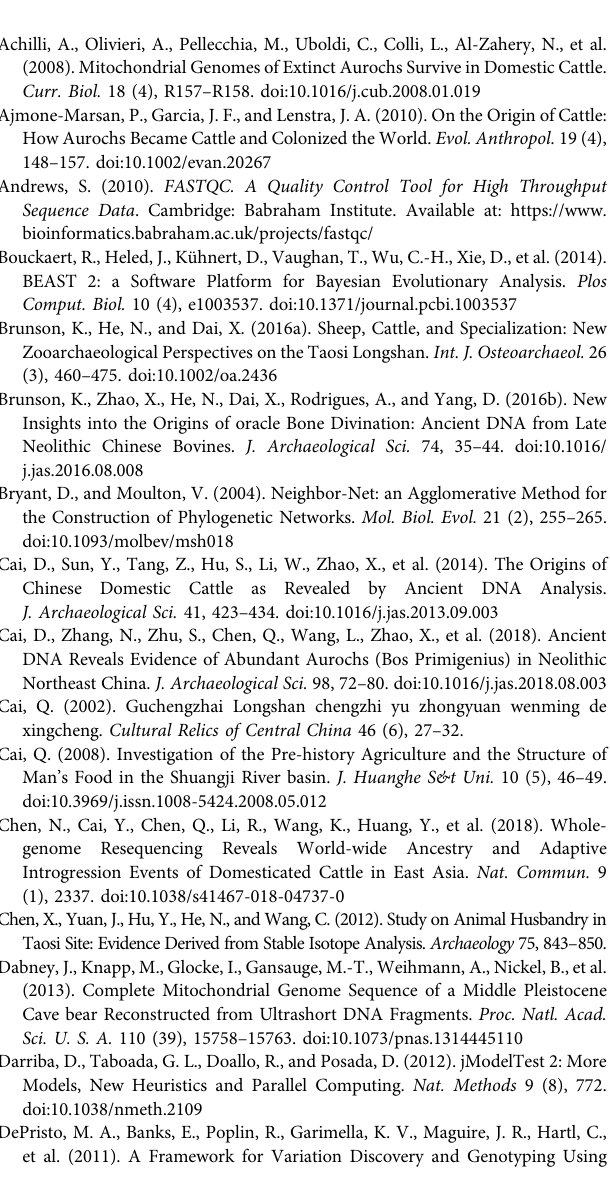
Supplementary Figure S4 | Phylogenetic tree of three ancient mitogenomes and 510 cattle of Bos genus. Supplementary Figure S5 | PCA of ancient samples and species from the Bos genus. (A) showstherelationshipofthreeancientsamplestoall Bos genuswhile (B) shows their relationship to the T haplogroup Bos genus. Supplementary Figure S6 | PCoA of ancient samples and species from the Bos genus. (A) shows the relationship of three ancient samples to the T haplogroup Bos genus while (B) shows their relationship to the T3/T4 species haplogroup Bos